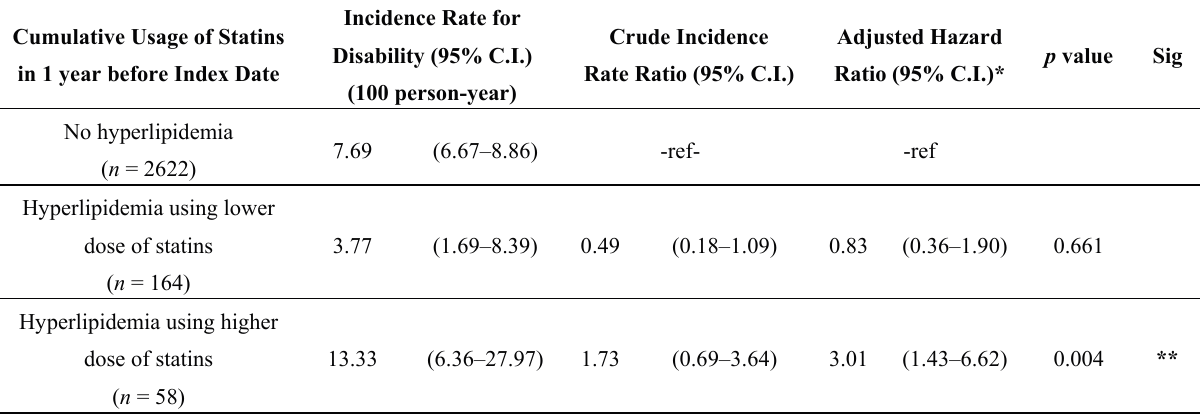
Figure 3. Cumulative incidence rate of permanent disability after lumbar SCI: Subgroup analysis among the normal, hyperlipidemia and severe hyperlipidemia groups. ( n = 2844, 1998–2010, Taiwan). Table 2. Incidence rate for permanent disability after lumbar spine injury by hyperlipidemia and use of statins ( n = 2844, 1998–2010,